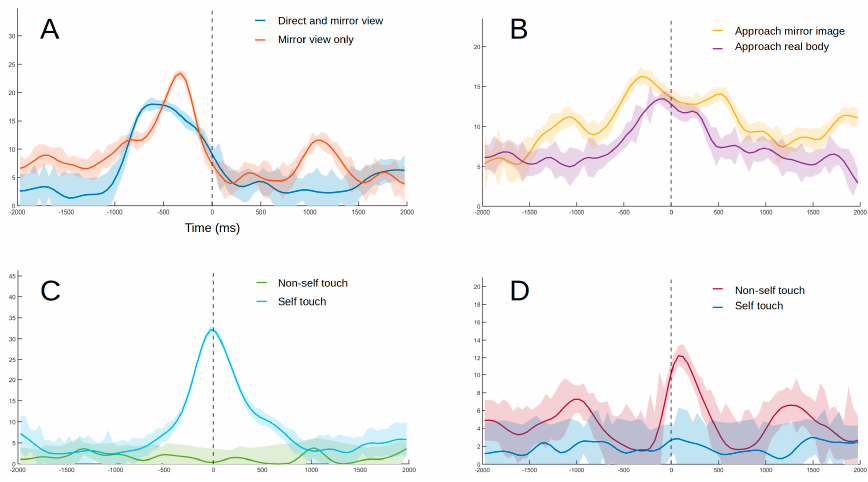
Figure 4. Example of responses from different types of neurons. The lines indicate smoothed average firing rates for all trials (Gaussian-weighted moving average of ten 50 ms samples). The shaded areas indicate the coefficient of variation (not smoothed) as a measure of consistency in firing rate between trials. ( A ) Example of a neuron with a visual receptive field near the self-body with responses maintained when seen through the mirror. The experimenter moves their hand toward the monkey’s abdomen without touching it. The results were confirmed after blocking the subject’s peripheral view with an opaque plate, with the stimulation site becoming visible only through the mirror. The dashed line indicates the moment of closest approach. ( B ) Example of a neuron responding to direct stimulation to the image in the mirror. The experimenter’s hand approaches the subject’s face projection in the mirror. The response to the hand approaching the subject’s real face follows a similar trend. The dashed line indicates the moment of closest approach. ( C ) Example of self-touch neuron. The monkey’s arm is moved by the experimenter until the hand touches the self-mouth. No response was observed when the same movement was repeated with an object sandwiched between the animal’s mouth and hand (non-self touch condition). No response was detected when mouth was touched by experimenter or external object either. The dashed line indicates touch onset. ( D ) Example of non-self touch neuron. The monkey’s left hand is touching the experimenter’s hand. No response was observed when touching the subject’s own opposite hand or forearm while rep- licating the same movement that was made when touching the experimenter’s hand (blue line). The dashed line indicates touch onset.